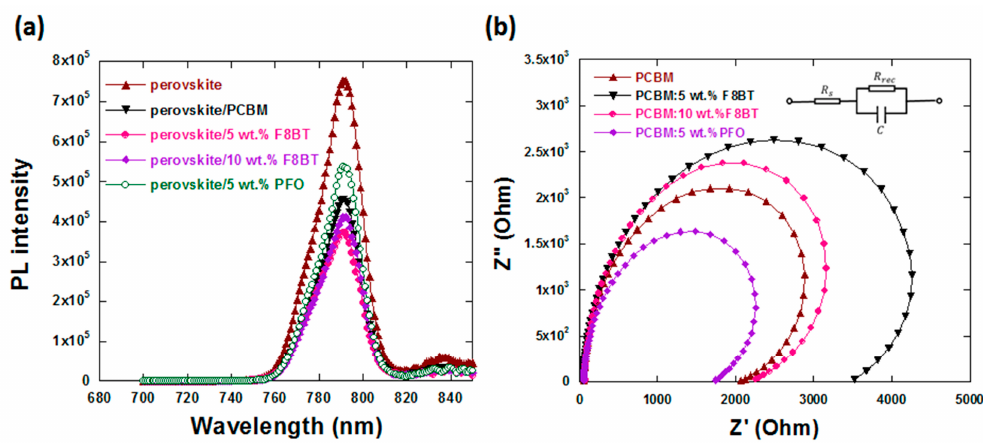
Figure 5. ( a ) The PL spectra of perovskite and perovskite/ETL double layered films and ( b ) Nyquist plots of PSCs with different ETLs.